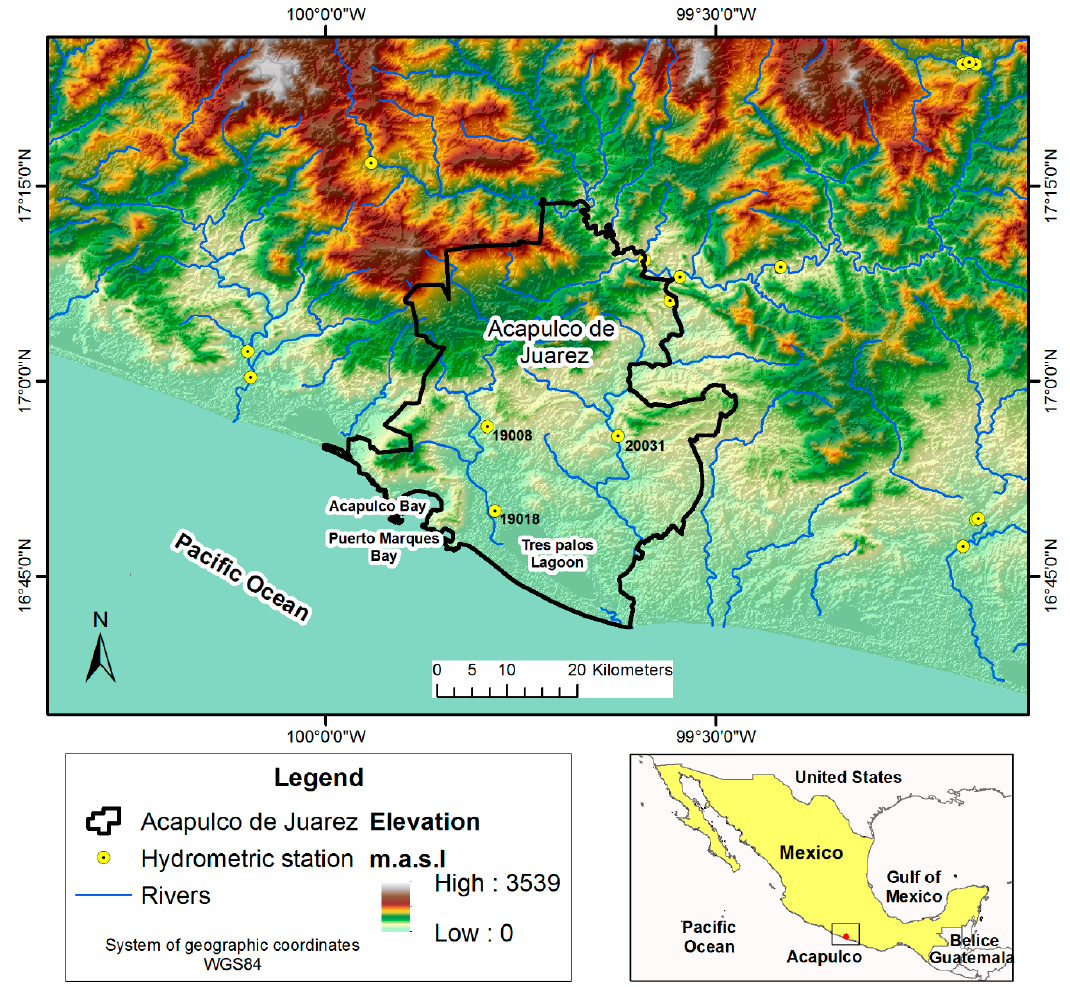
Figure 1. Study case location, water bodies and elevation [40].